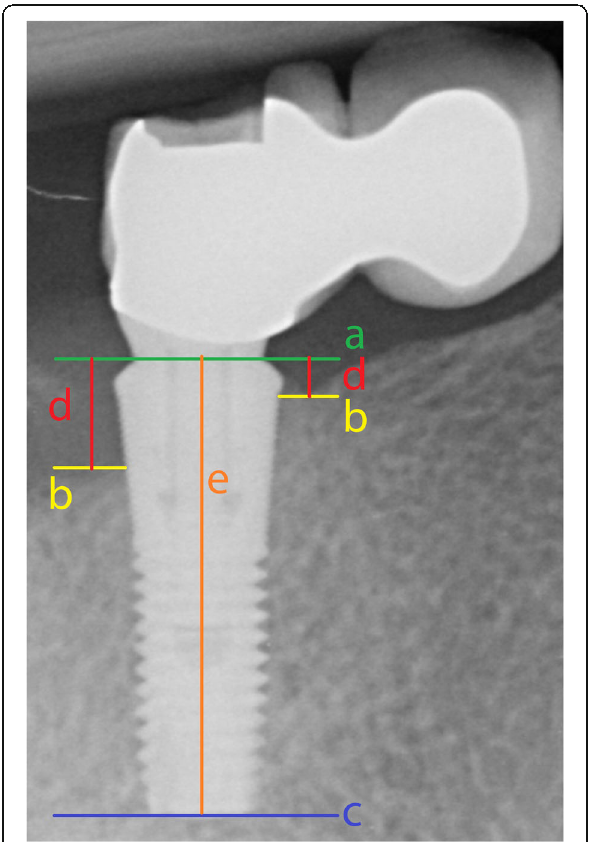
Fig. 2 Measurement of marginal bone level at the mesial and distal side of the implant: Line a, reference line at interface of implant and abutment; line c, line at the apex of the implant; line e, length of the implant for calibration; line b, line through the first bone-to implant contact; line d, measurement of marginal bone level from reference line a to bone-to-implant contact line